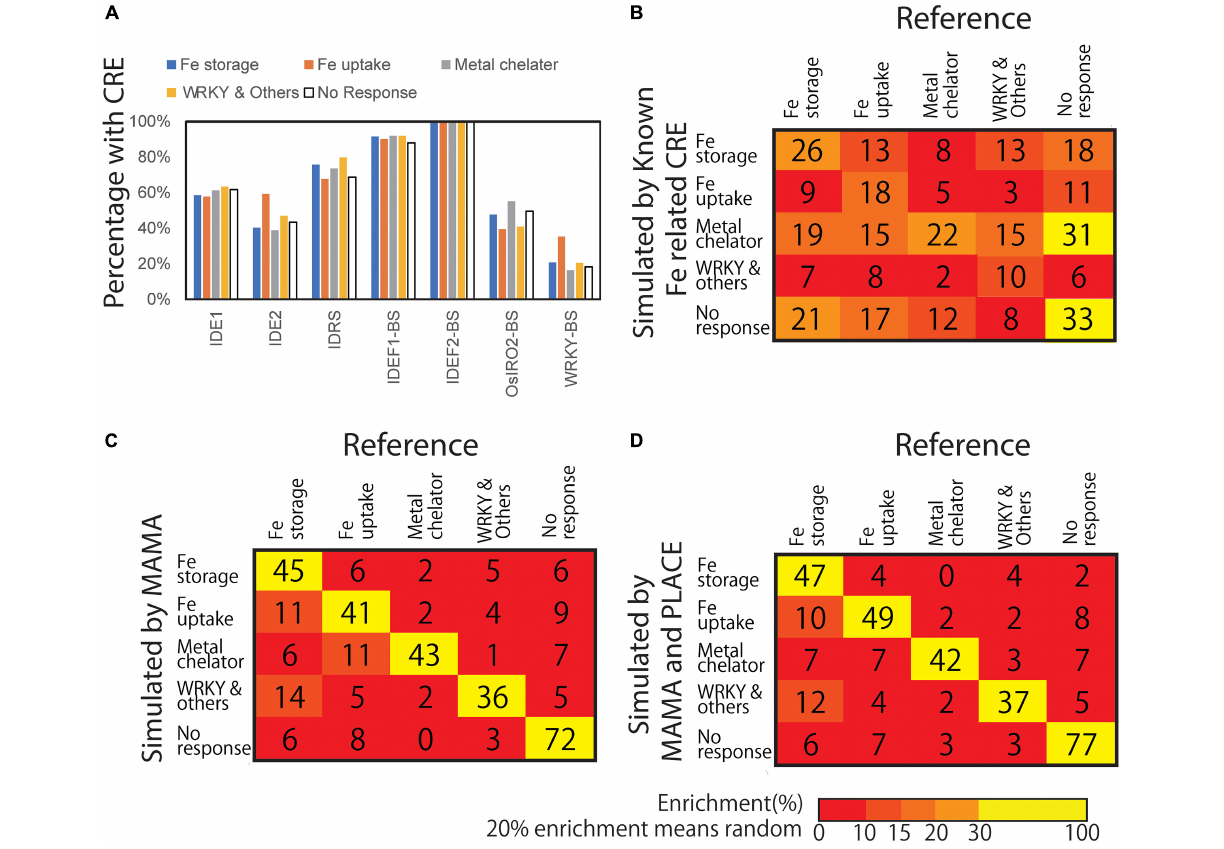
Frontiers in Plant Science |